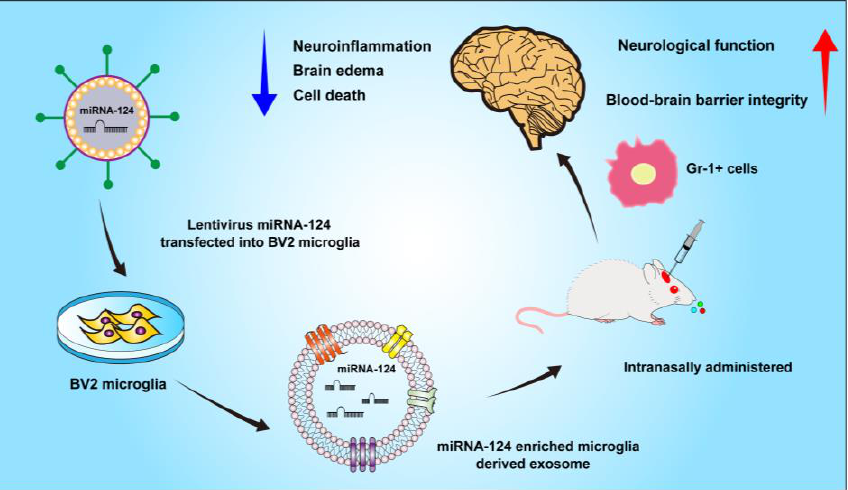
Figure 8. Summary of the effect of miRNA-124-enriched microglia-derived exosomes after ICH. Lentivirus vectors expressing miRNA-124 were transduced into BV2 microglia. The cell culture su- pernatant was collected and ultracentrifuged. ICH was induced in mice by bacterial collagenase, and the mice received miRNA-124-enriched microglia-derived exosomes via intranasal administration. miRNA-124-enriched microglia-derived exosomes reduced brain edema, cell death and neuroinflam- mation in ICH mice. miRNA-124-enriched microglia-derived exosomes improved BBB integrity and neurological function. The beneficial effects of miRNA-124-enriched microglia-derived exosomes were associated with amelioration of inflammatory milieu and a reduction in Gr-1 + myeloid cell infiltration into the brain.